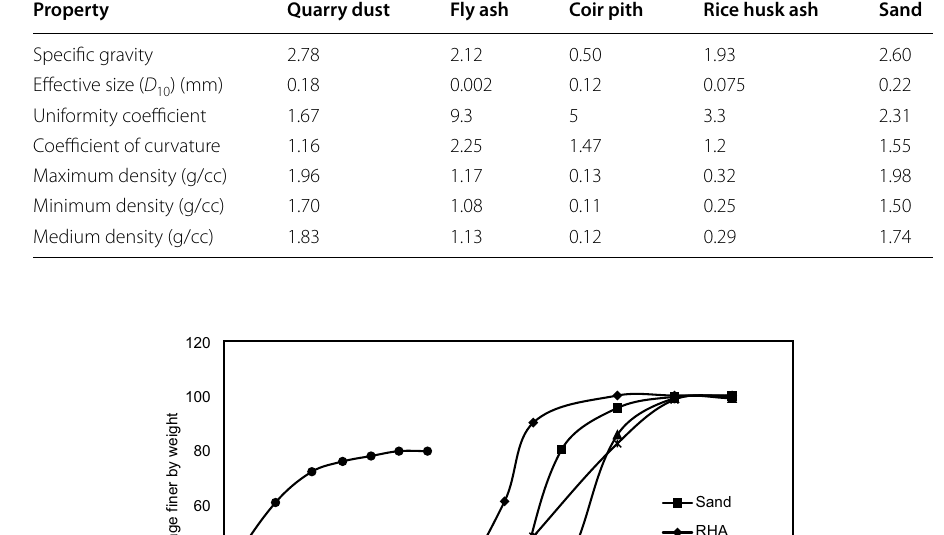
Table 2 Properties of the drain materials used in the study Property